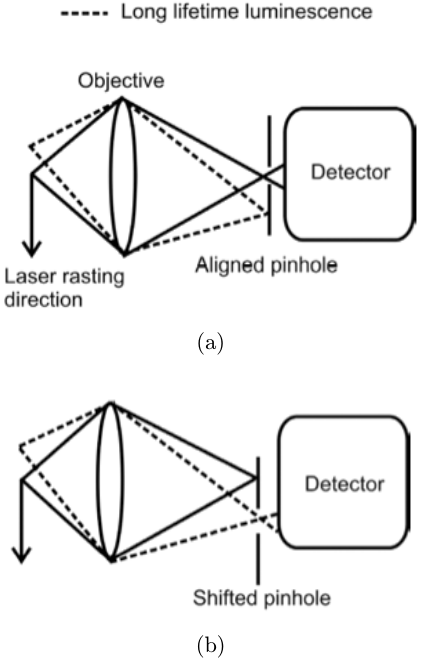
Fig. 1. The pinhole shifting technique. By shifting the pinhole successively out of its optimally aligned position (a), through a series of steps (e.g., b), collection of sequential time-delayed phosphorescence emission in the lagging direction of the raster scanned two-photon excitation is achieved by employing appropriate laser beam scanning speeds. Reproduced with permission from Ramshesh 2007.